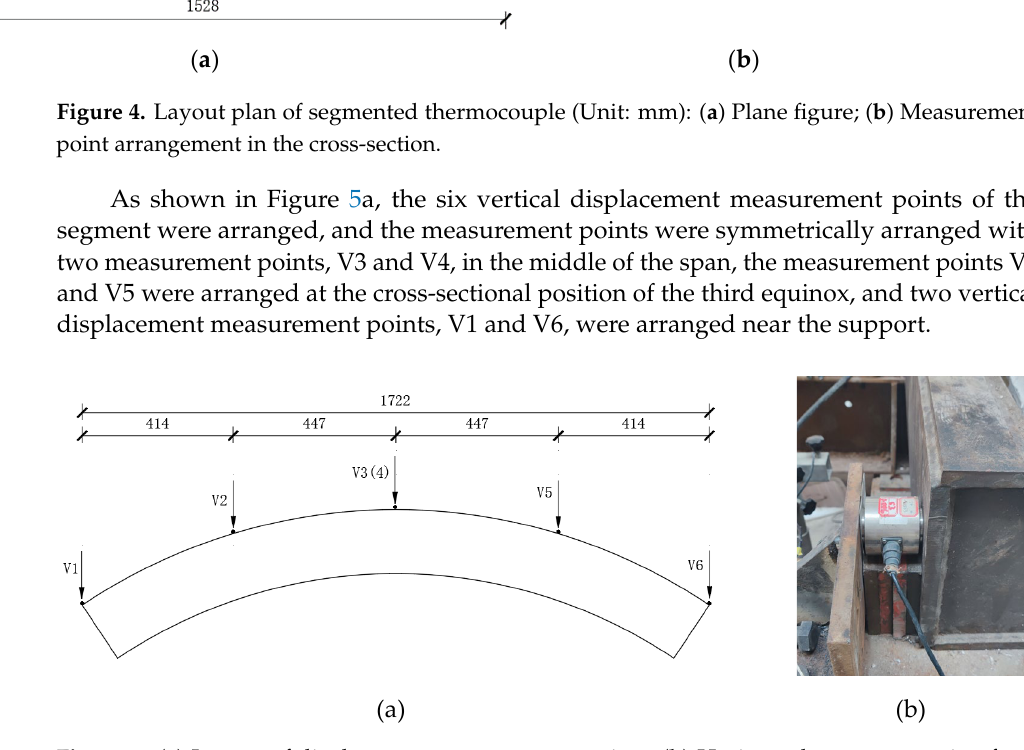
Figure 5. ( a ) Layout of displacement measurement points; ( b ) Horizontal support reaction force measuring device.